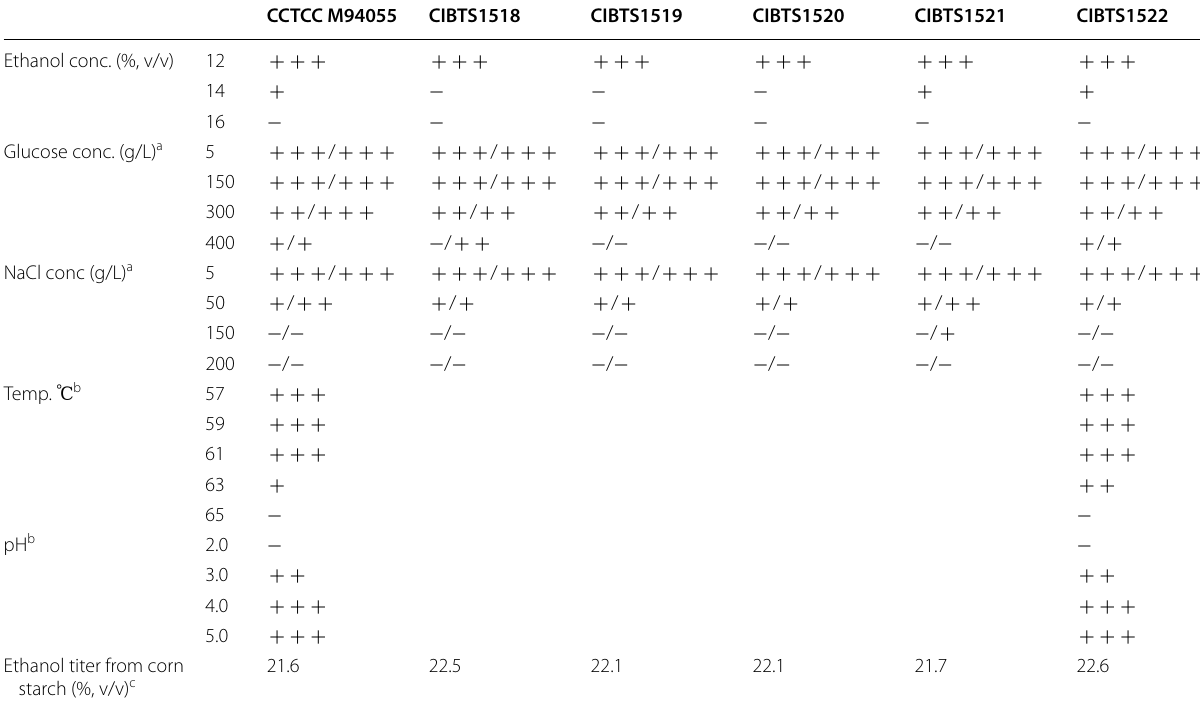
Table 2 Physiological characteristics of the glucoamylase producing strains and the parental